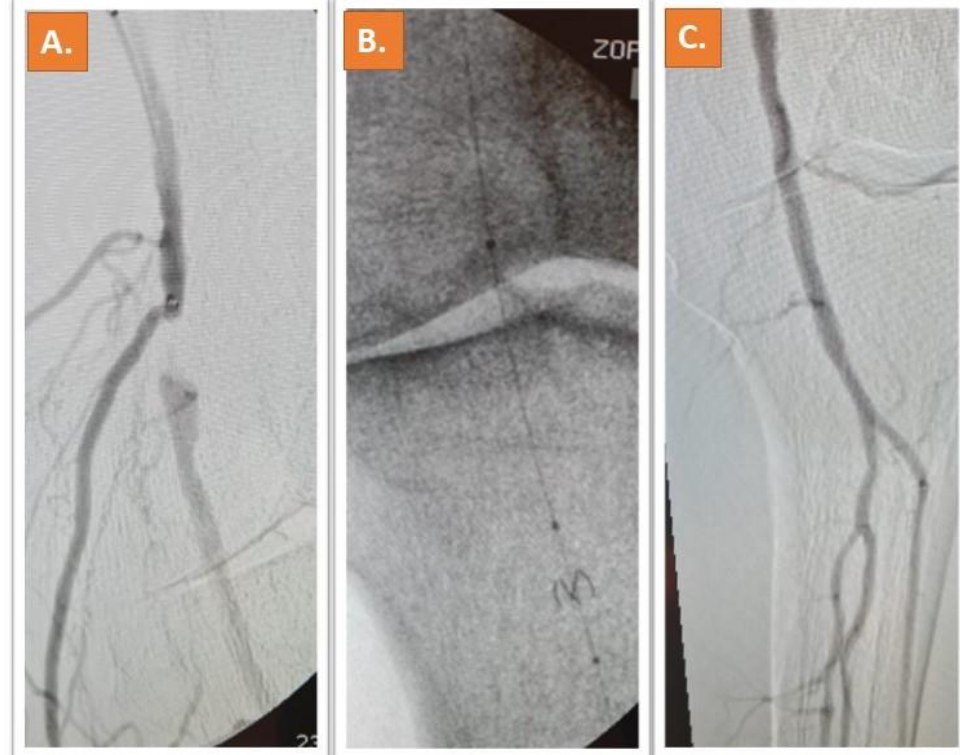
Figure 1. A chronic moderately calcified occlusion of the popliteal artery can be depicted in ( A ). Treatment was successfully performed with Jetstream rotational atherectomy after placement of a filter system ( B ). The result after Jetstream-assisted atherectomy and DCB can be appreciated in ( C ) [11].